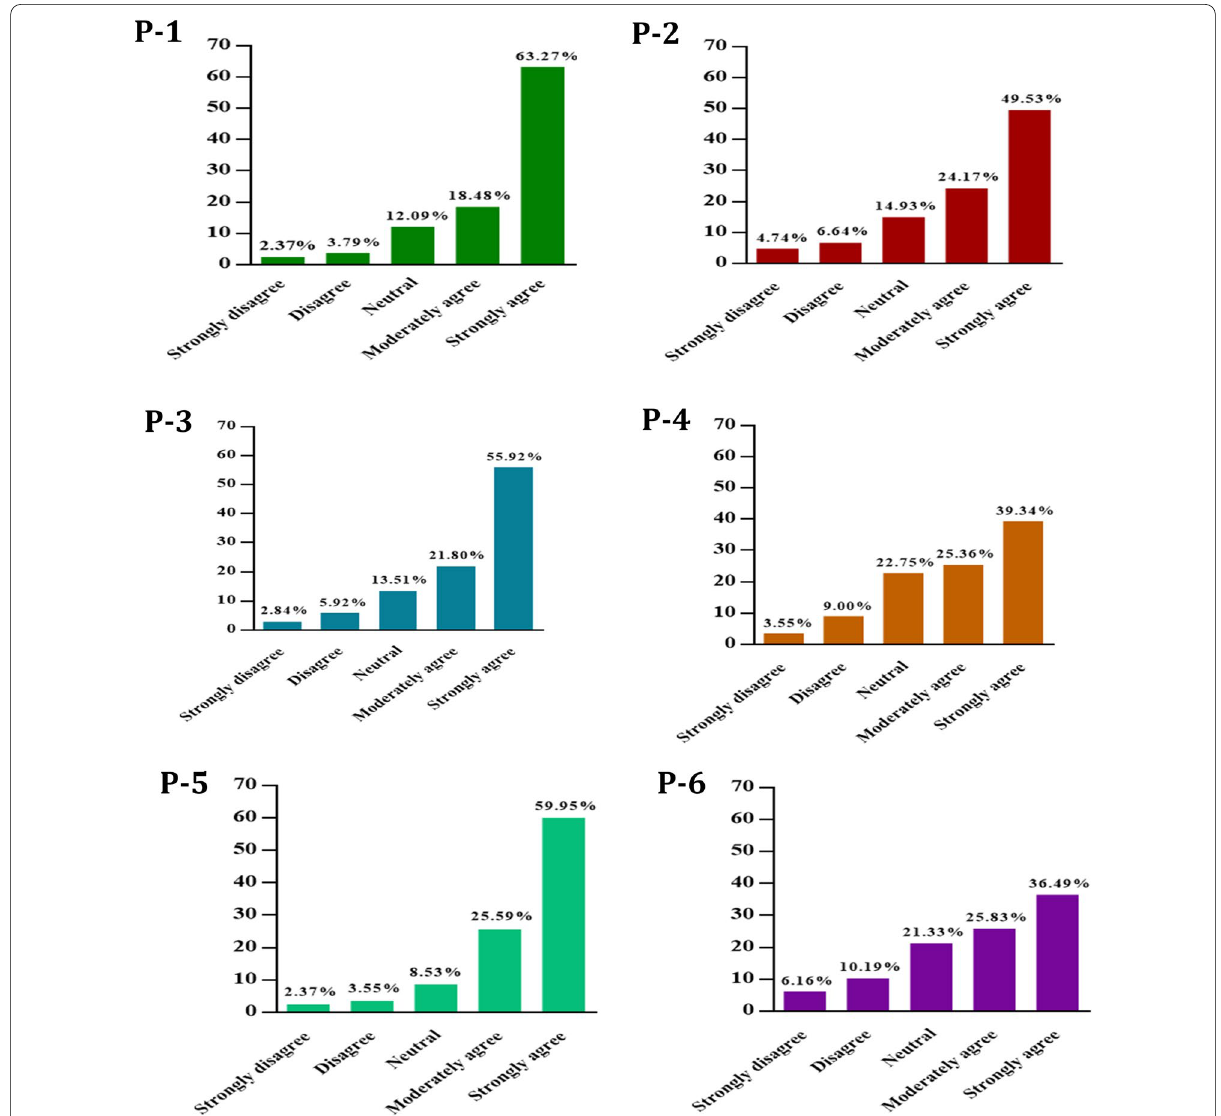
Fig. 1 The distributions of six items’ (denoted by P-1 to P-6) mucormycosis perception